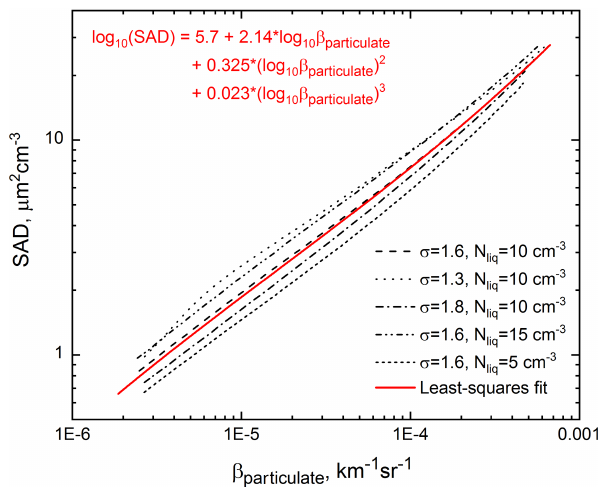
Figure 7. Theoretical particulate volume density (VD) vs. β particulate for various combinations of liquid particle number density N liq and lognormal geometric standard deviation σ , along with the third-order polynomial least-squares